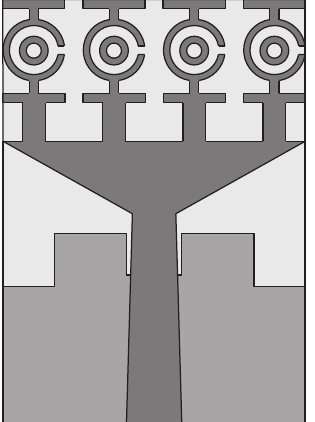
Figure 40: A metamaterial UWB antenna [102]. The four cells composed of two capacitance-loaded strips (CLSs), a split-ring, and a gapless ring, forming the metamaterial loading of the upper edge of the triangular patch, are evident in the figure. Dark gray upper metal face, medium gray bottom metal face, and light gray dielectric